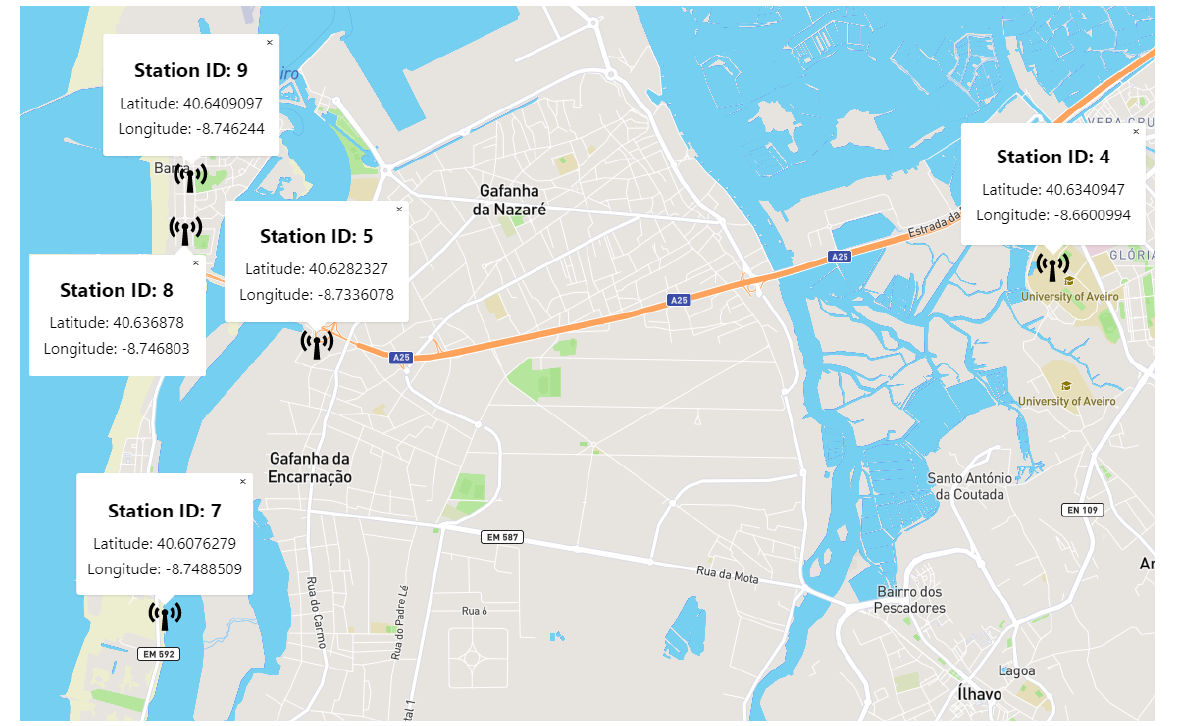
Figure 6. Web-based dashboard and geographical location of the RSUs in the